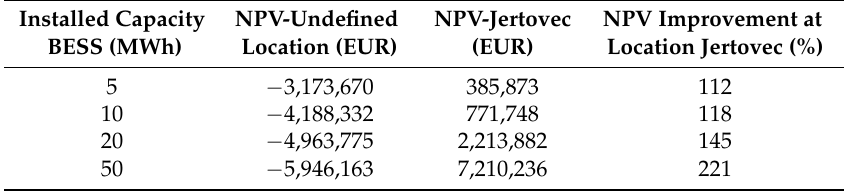
Table 6. NPV indicators for 75% reduced BESS investment cost: undefined location and location Jertovec.